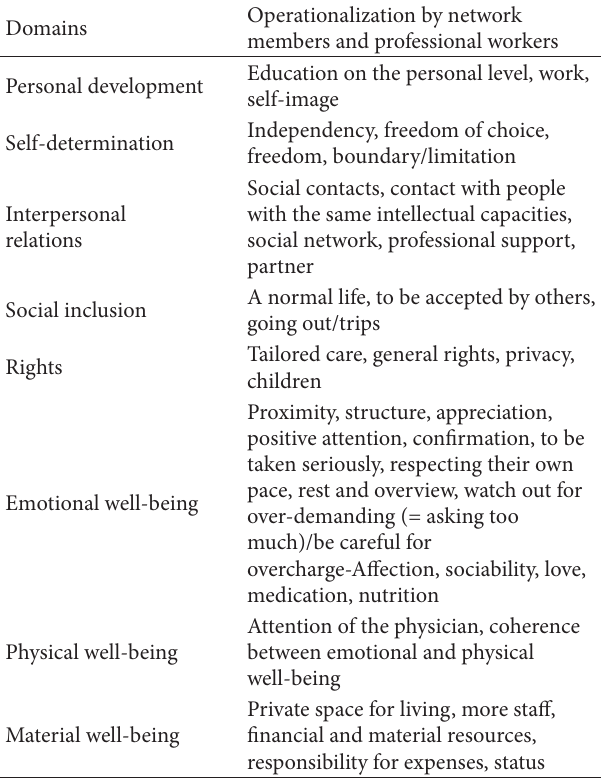
Table 2: Operationalization of QOL domains into indicators by professional and natural network members